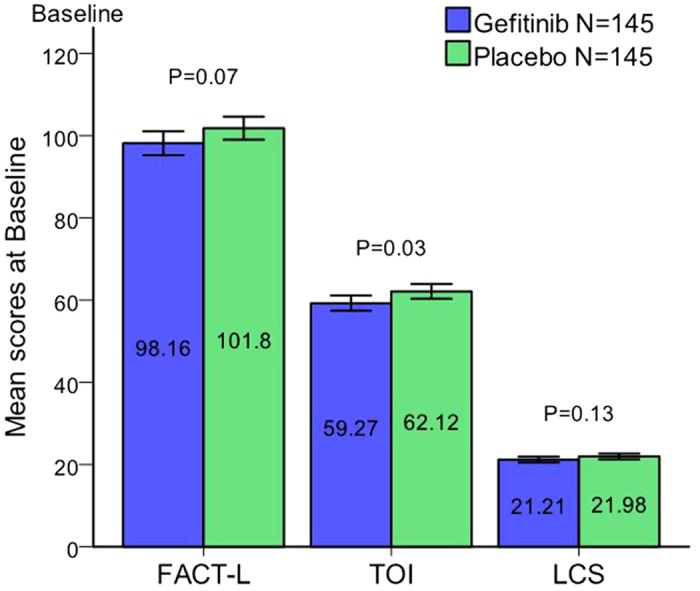
Bar charts of the quality of life status of each arm at baseline.290 patients were evaluable for quality-of-life (EFQ) analyses at baseline (gefitinib arm 145, placebo arm 145). FACT-L and LCS scores are comparable between the two arms, while the TOI score in placebo arm is significantly higher than that in gefitinib arm.